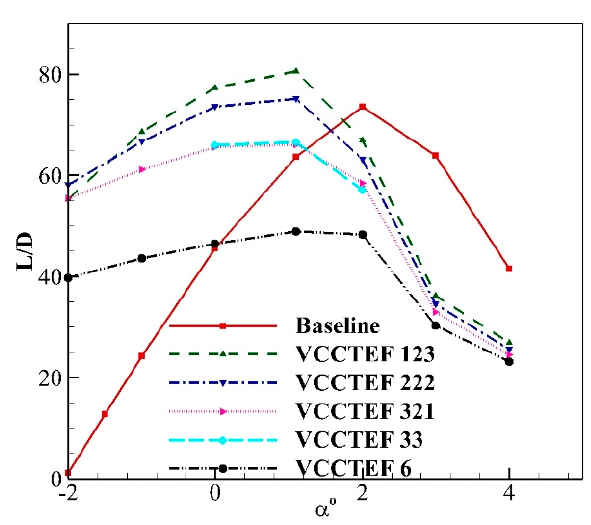
Figure 25. Lift to drag ratio, L/D variation with different angles of attack, α .